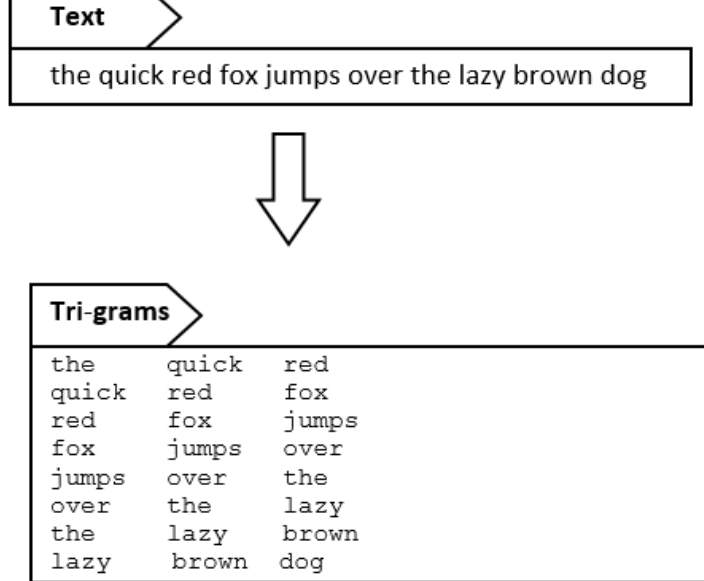
Fig. 2. tri-gram formation